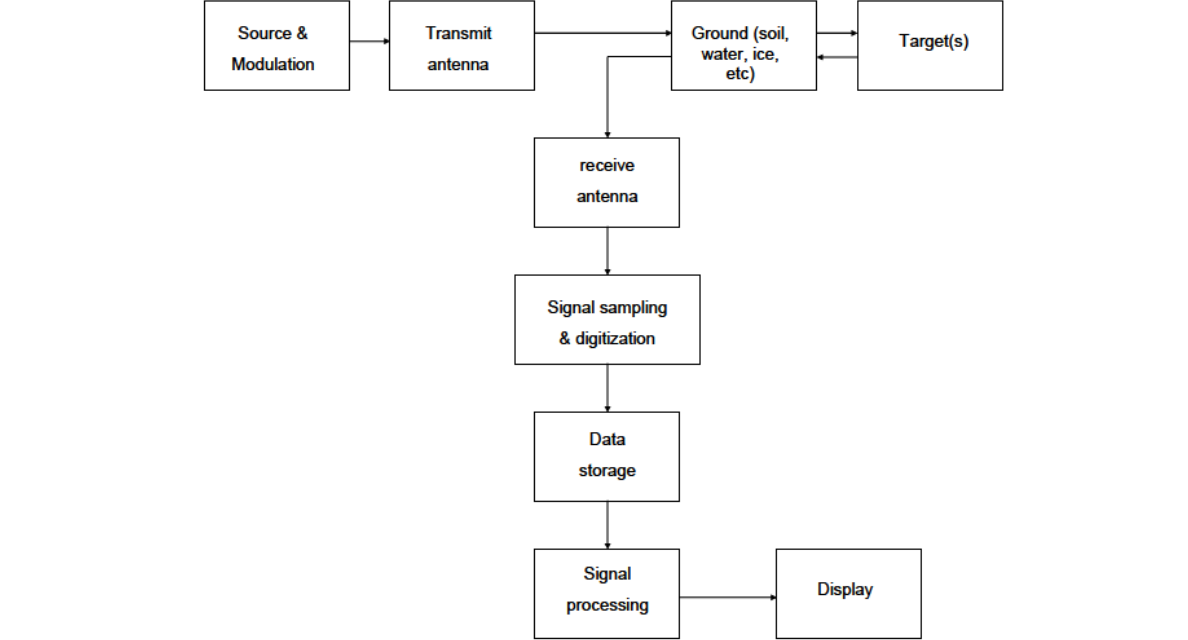
Fig.1: Tthe block diagram showing the operation of a typical base-band subsurface RADAR system